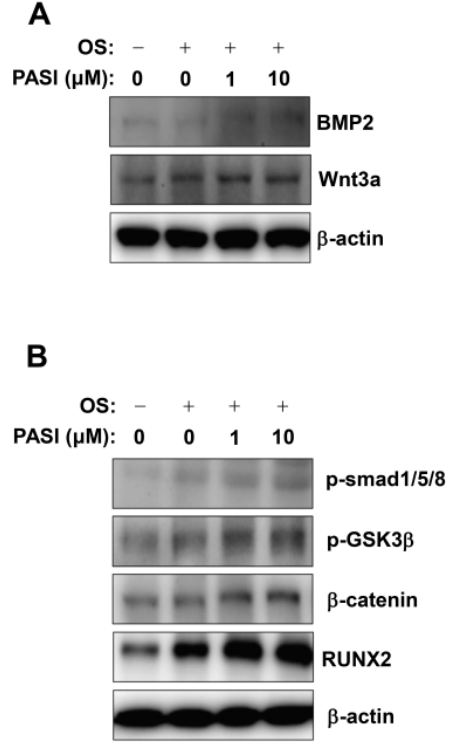
Figure 5. Effects of PASI on BMP2 and Wnt3a/ β -catenin signaling during osteoblast differentiation. ( A , B ) The expression of BMP2 and Wnt3a proteins ( A ), and the phosphorylation of Smad1/5/8 (p-Smad1/5/8) and GSK3 β (p-GSK3 β ) proteins, and the expression of β -catenin protein ( B ) were analyzed using western blot analysis. β -actin was used as an internal control to normalize the level of total lysates.